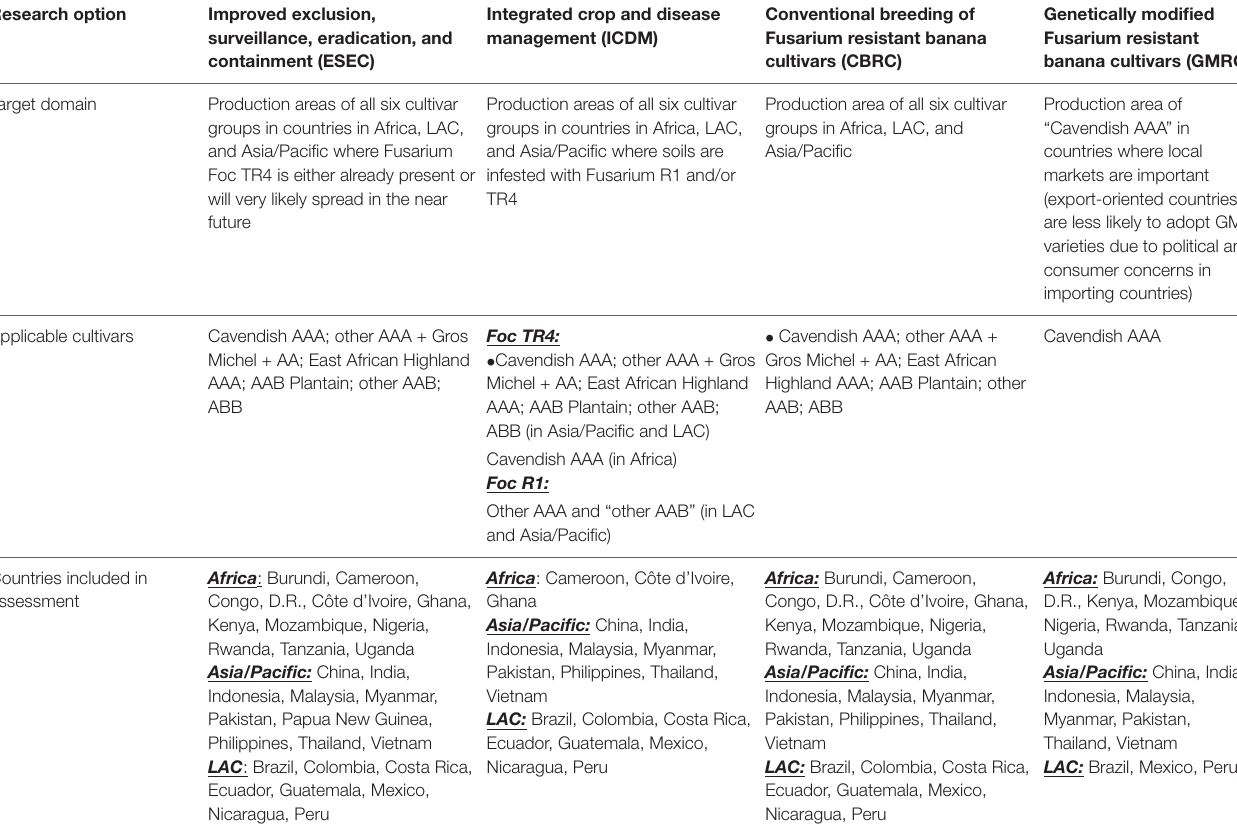
TABLE 2 | Target domains for the assessed research options to address Fusarium wilt of bananas. Research